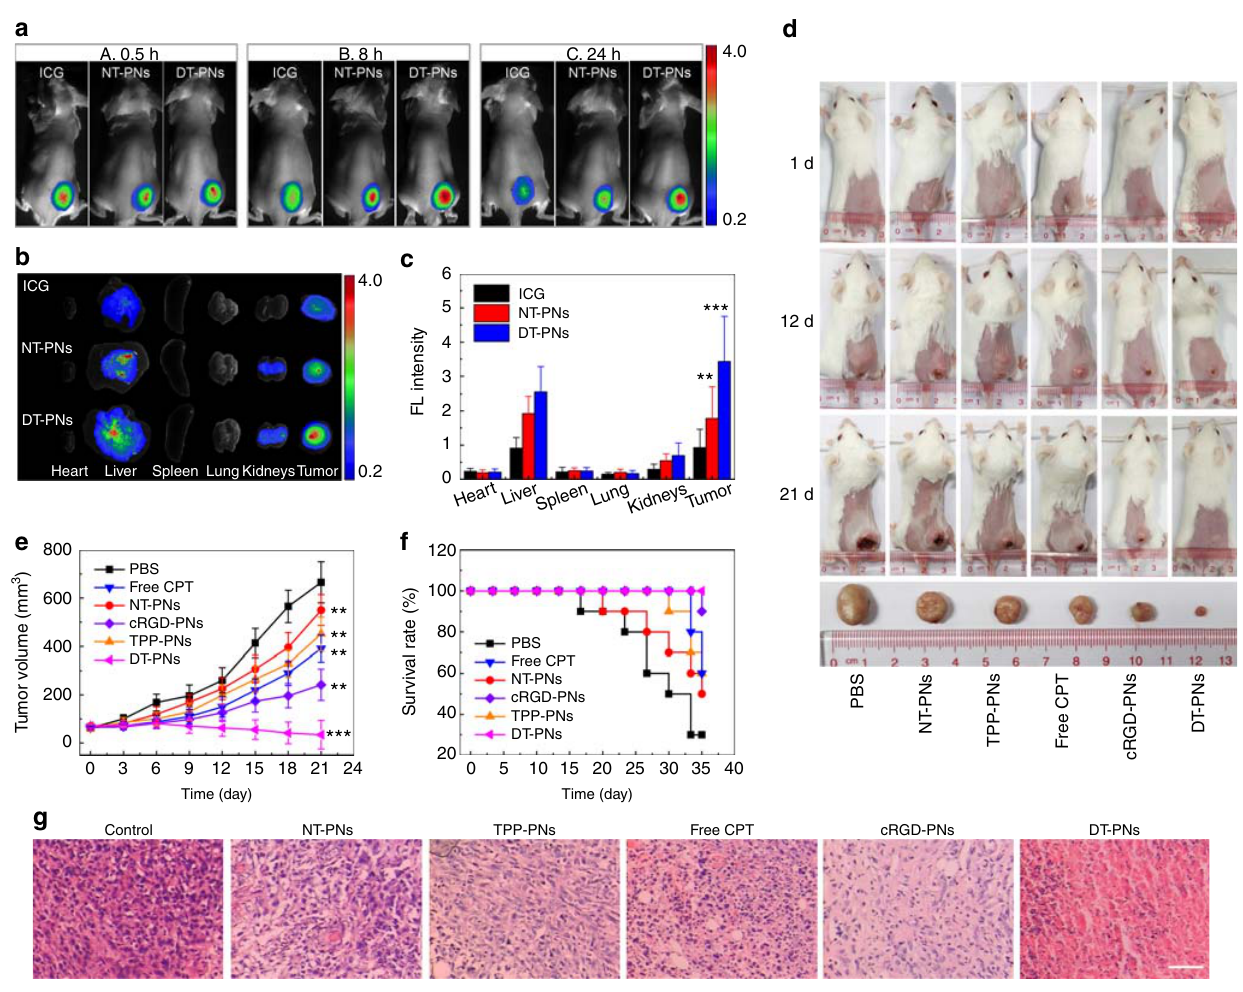
Fig. 8 In vivo biodistribution and cancer inhibition evaluation. a Time-lapse NIR fl uorescence images of the tumor after tail vein injection with free ICG, NT- PNs and DT-PNs loaded with ICG, respectively. b Fluorescence images of major organs and tumors upon 24 h post-injection with three samples. c The biodistribution of free ICG, NT-PNs, and DT-PNs in mice determined by the averaged fl uorescence intensity of each organ and tumor. The mean value was calculated by the t test (mean ± s.e.m. n = 5). ** p < 0.01, *** p < 0.001, compared with the ICG group. d Representative photographs of mice after different treatments, the bottom tumor obtained from each treating group at 21 d. e Tumor volume and f survival rate of 4T1 tumor-bearing mice after different treatments. The mean value was calculated by the t test (mean ± s.e.m. n = 6). ** p < 0.01, *** p < 0.001, compared with the PBS group. g Representative images of H&E stained tumor sections from different groups (scar bar, 50 μ